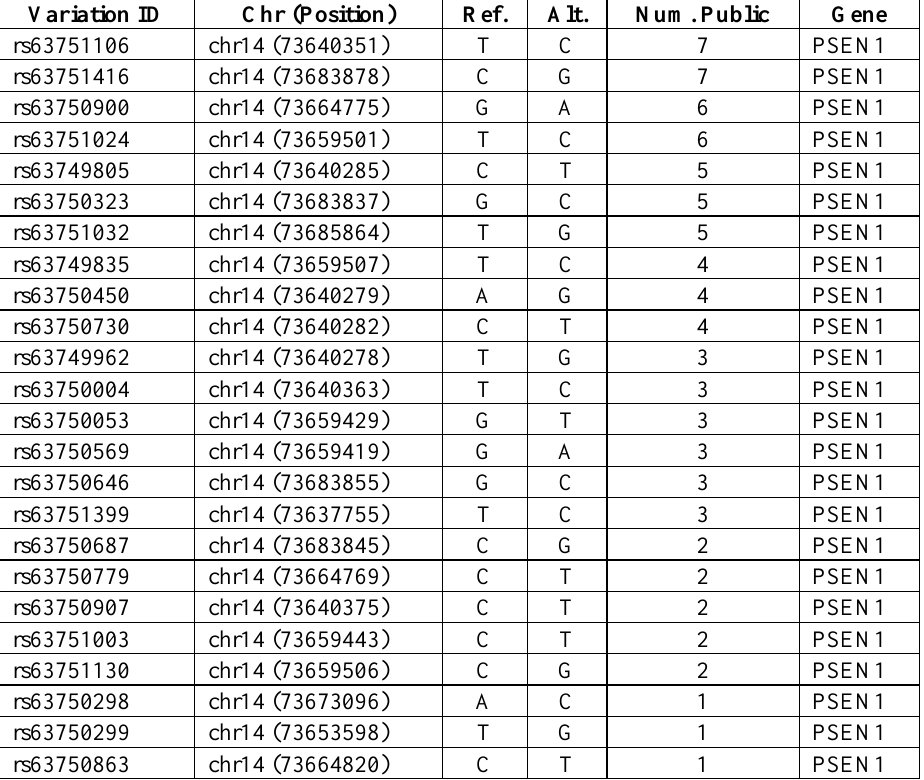
Table 6 . Relevant variants for Early Onset Alzheimer’s Disease ordered by number of associated publications. Ref . represents the original allele, Alt. represents the change which has occurred in the location of the chromosome specified by Chr (Position), and Num. Public. represents the number of publications associated with the variation. Chr (Position)